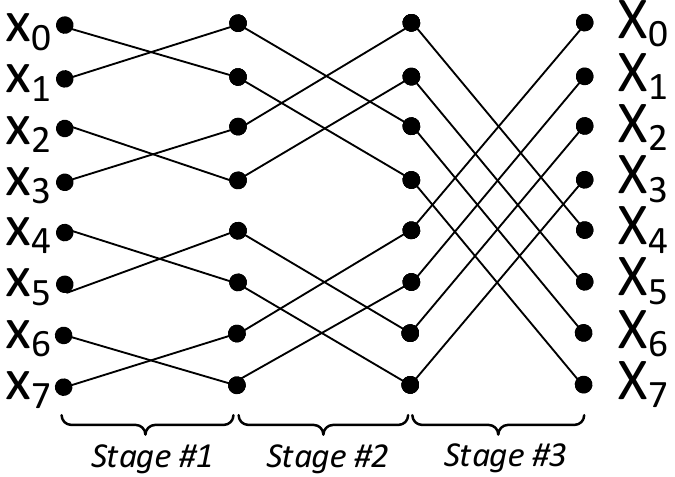
Figure 3. 8-point traditional